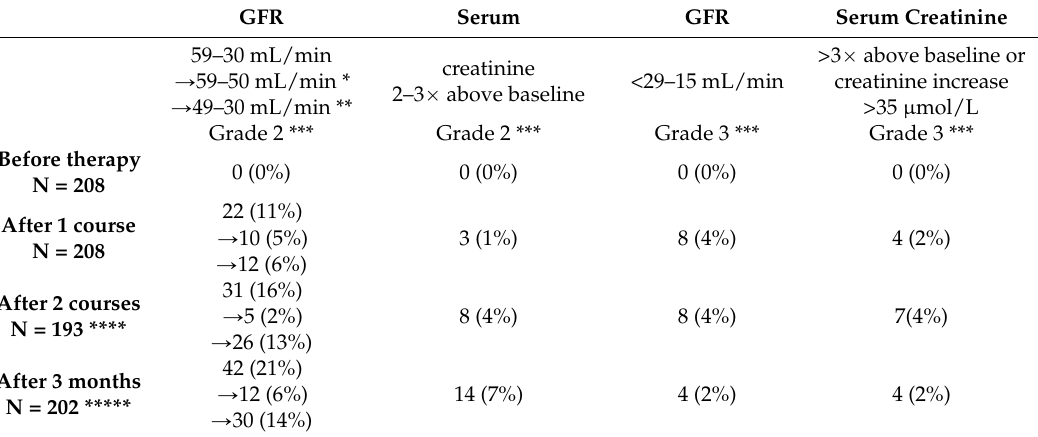
Table 3. Grades of nephrotoxicty.